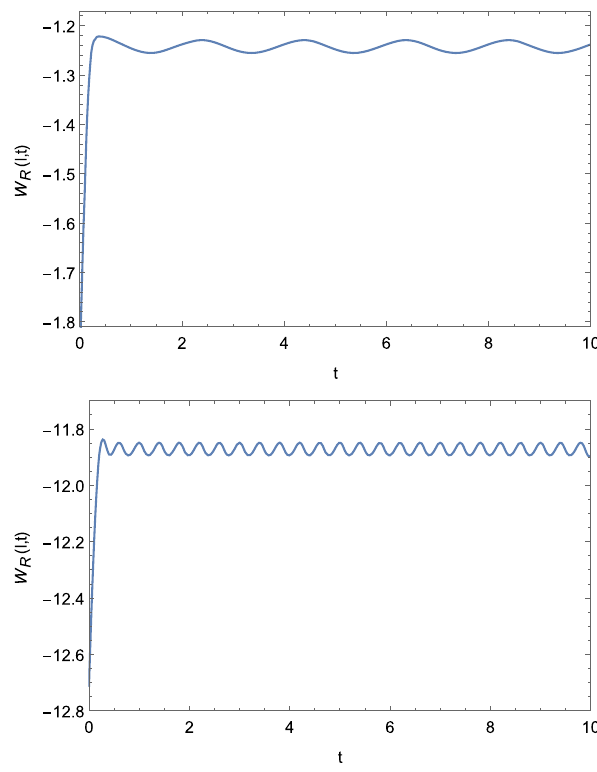
l = 1. The static potential is V ( l ) = − 0 . 4488 , − 1 . 2422 , − 4 . 1120 and − 11 . 8713 corresponding to ν = 1 , 2 , 3 and 4, = 0 . 159, and f